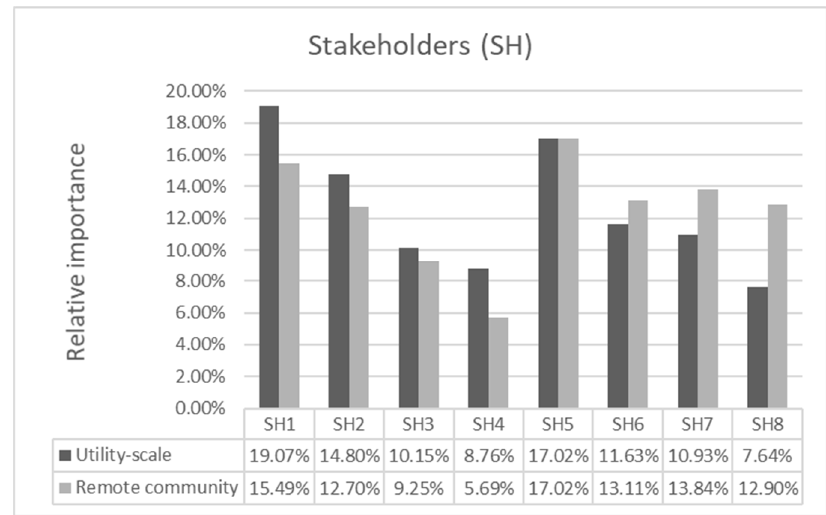
Figure 12. Relative importance of SH for the application market.